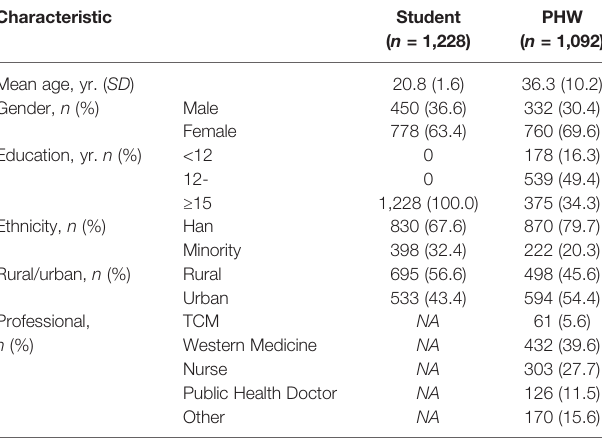
TABLE 2 | Demographic characteristics of medical student and primary health care worker.